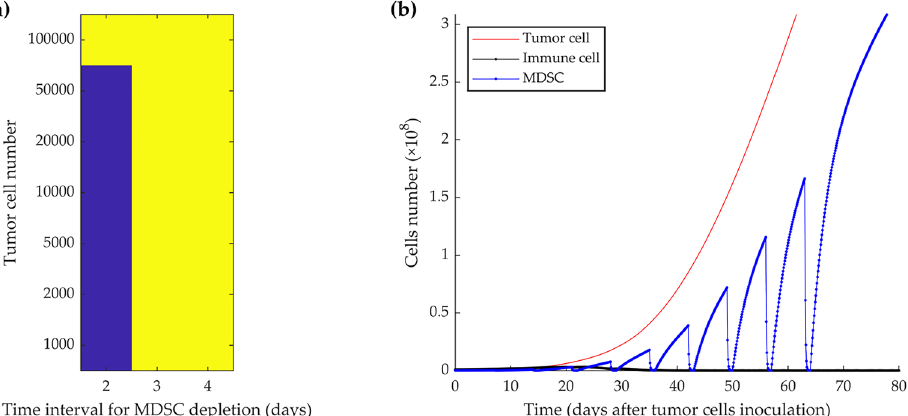
Figure 3. Simulation of how different time intervals of MDSC depletion from mice bearing growing tumors can induce cancer dormancy or fail to control tumor growth. For up to 70,000 initial tumor cells and starting